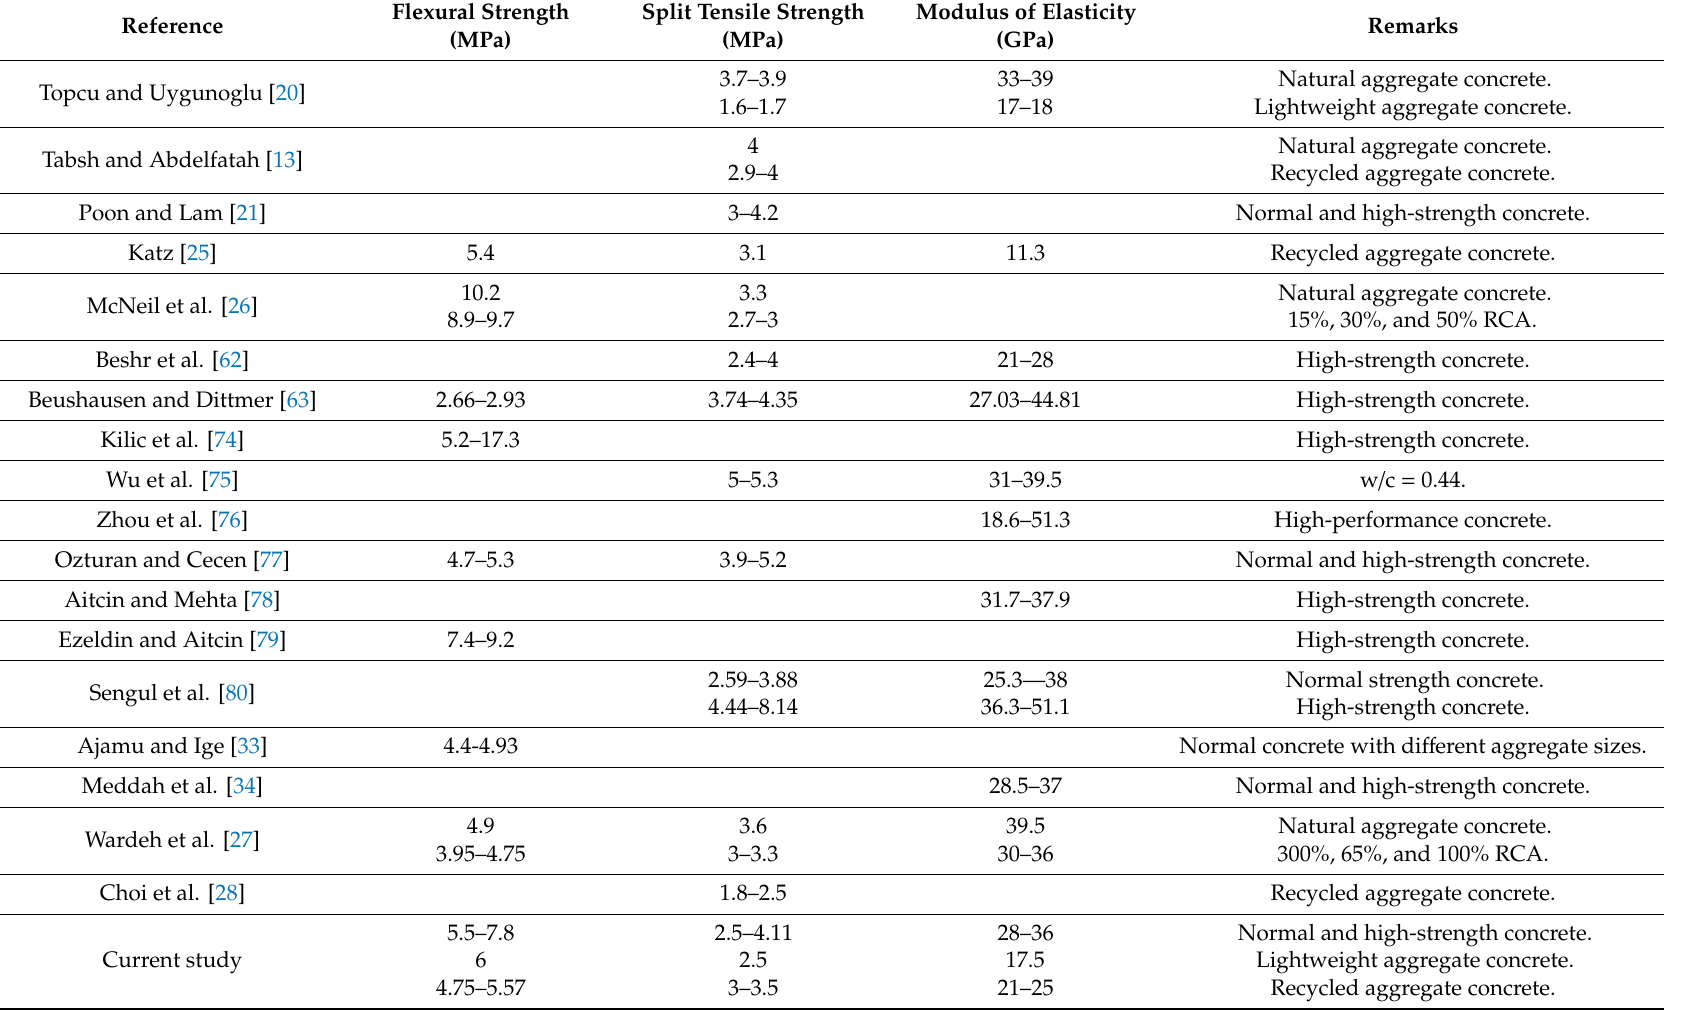
Table 14. Results of mechanical properties from literature and the current study results.